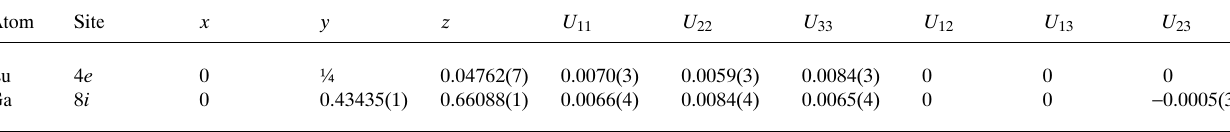
Table 2. Atomic coordinates and displacement parameters (in Å 2 )